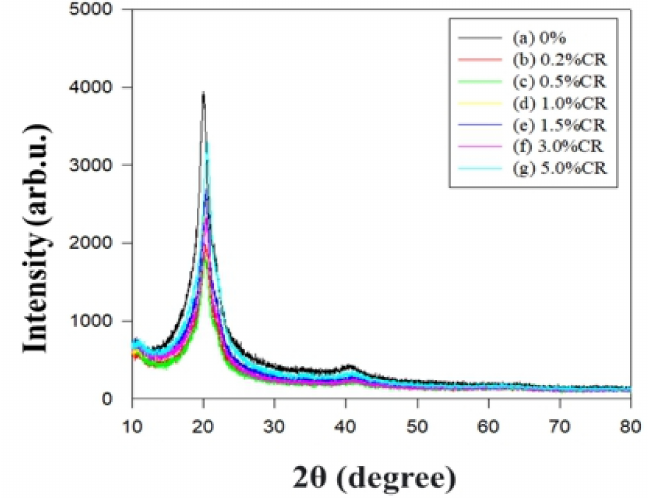
Figure 9. X-ray diffraction (XRD) scans of the PBT–EVOH polymer composite